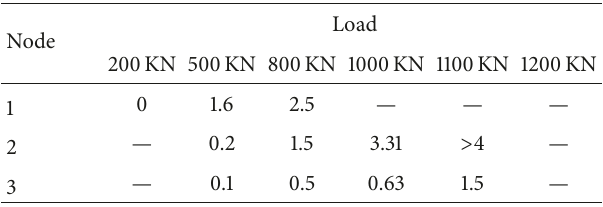
Table 5: The development status of the maximum crack width (unit: